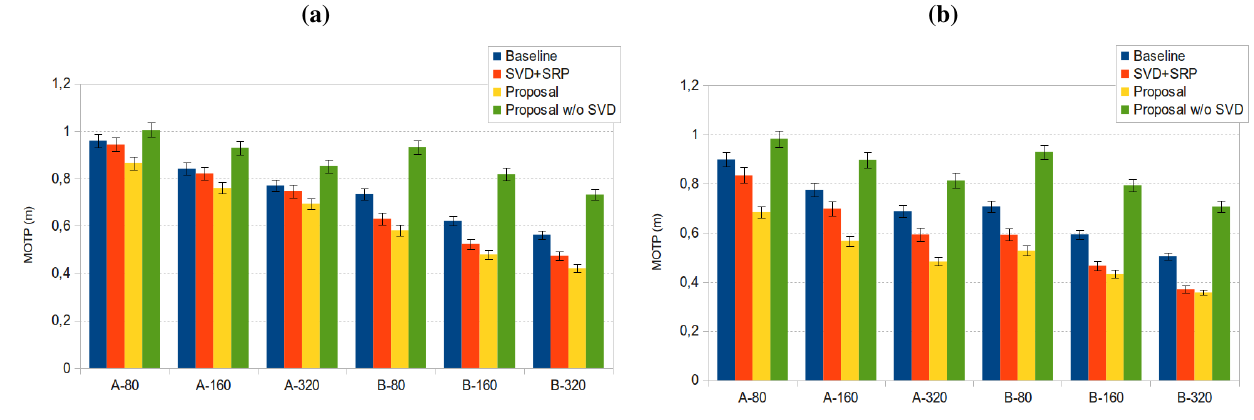
Figure 15. Best MOT P results for both microphone setups (A, B) and all frame sizes (80, 160 and 320 ms), with 95% confidence intervals, (a) for sequence seq02 and (b) for sequence seq03 .